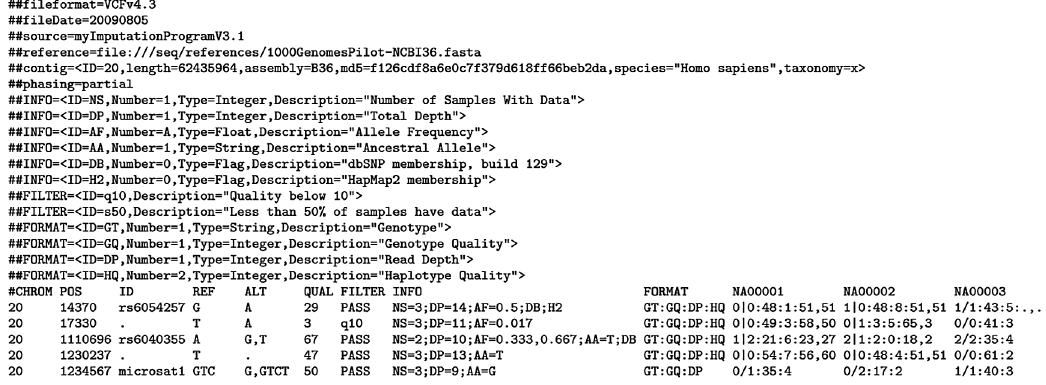
Figure 1. Example Variant Call Format (VCF) file structure, including meta-information lines and data lines (from